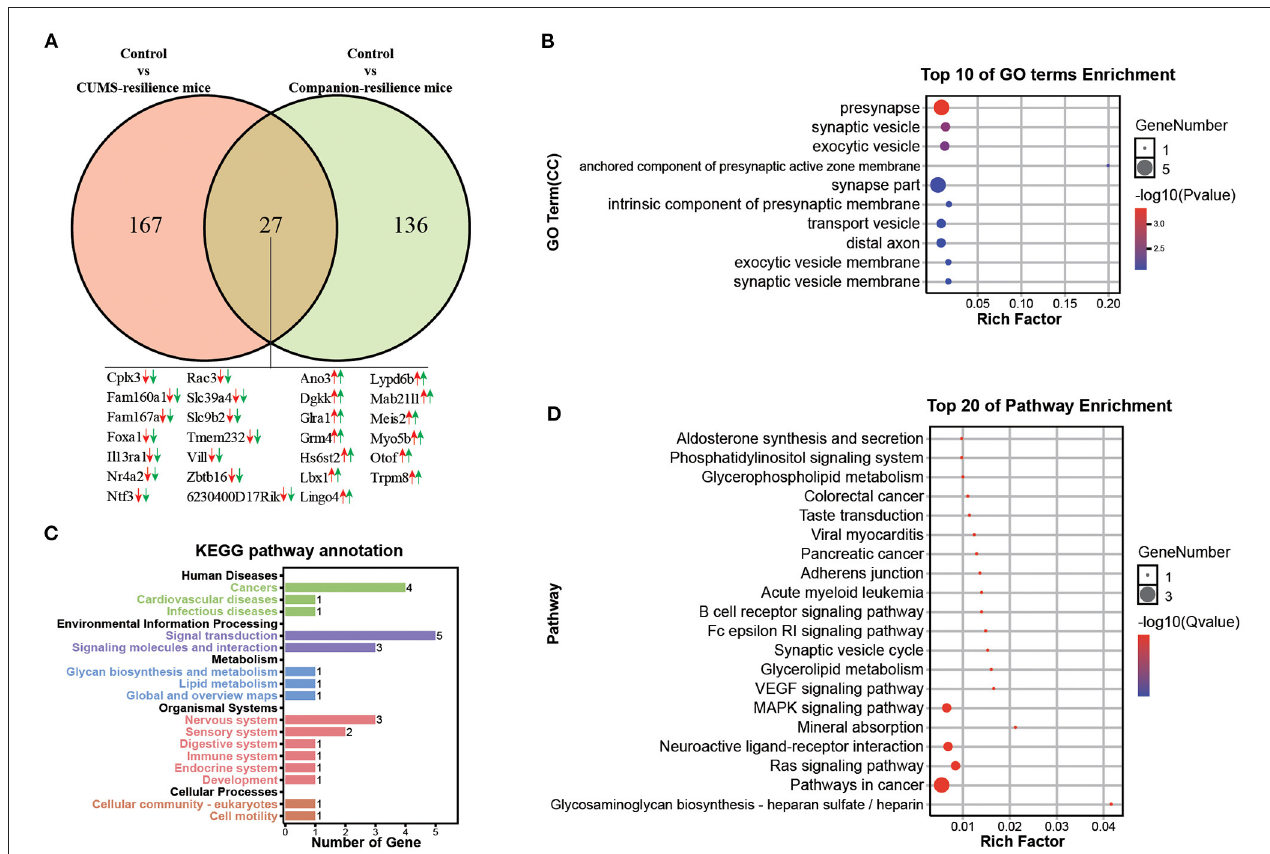
FIGURE 4 | Functional analysis of DEGs associated with resilience in VTA. (A) Screening of DEGs associated with resilience in Control vs. CUMS-resilience mice and Control vs. Companion-resilience mice through Venn diagram. (B) The histogram demonstrates common DEGs GO enrichment results, CC (cellular component). (C) KEGG pathway annotation for common DEGs. (D) The histogram demonstrates common DEGs KEGG pathway enrichment results, top 20 of pathway enrichment were